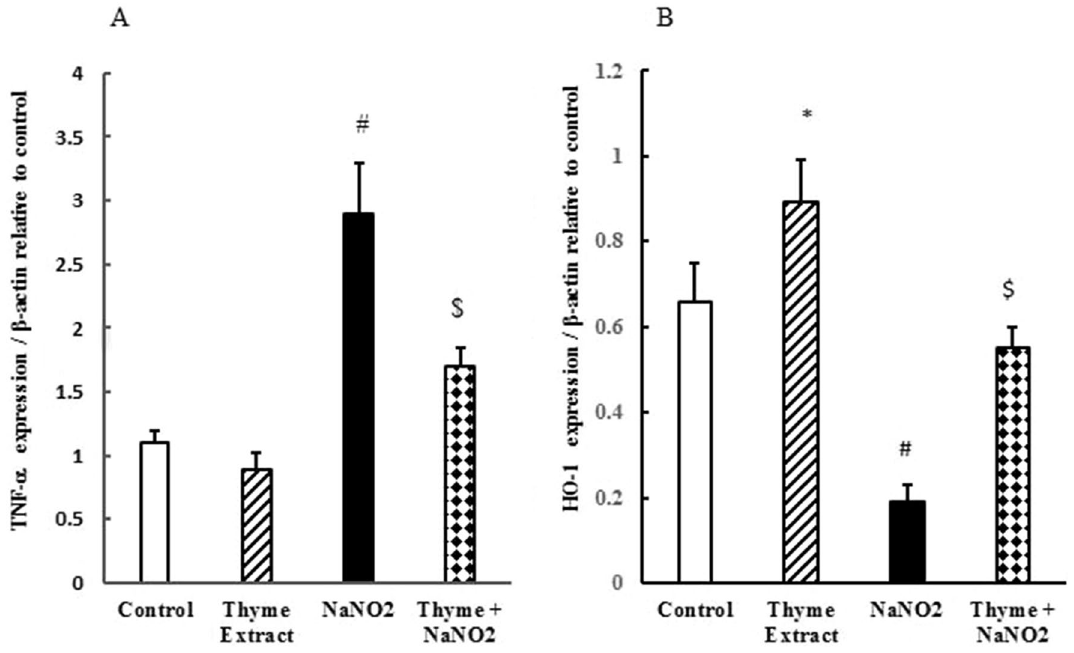
Figure 2. Ameliorative effect of T. vulgaris extract on mRNA expression of TNF-α ( A ) and HO-1 ( B ) in NaNO 2 -treated mice. Graphic presentation of liver mRNA expression by qRT-PCR analysis of TNF-α ( A ) and HO-1 ( B ) in different groups of mice relative to β-actin. * p < 0.05 versus the control group; # p < 0.05 versus the control and T. vulgaris extract groups; and $ p < 0.05 versus the NaNO 2 -treated